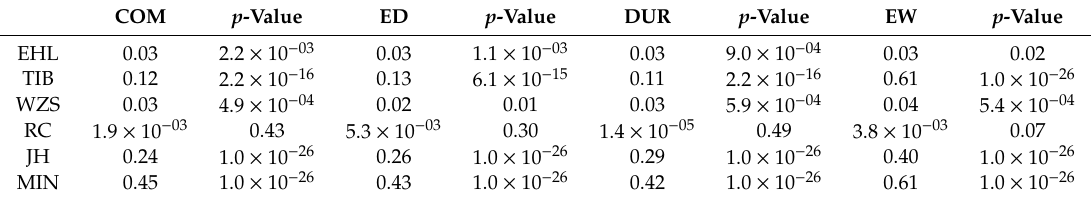
Table 2. D-statistics for six indigenous Chinese breeds vs. four Western